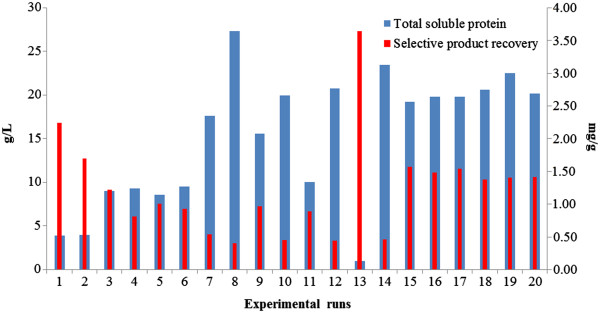
Total soluble protein (g/L) and selective product recovery (mg/g) of cell disruption process by the effects of three variables. Total soluble protein was measured using Bradford assay and selective product recovery was calculated based on the ratio of specific protein concentration measured by ELISA method to total soluble protein released. Experimental runs here mentioned are referred as in Table 1.